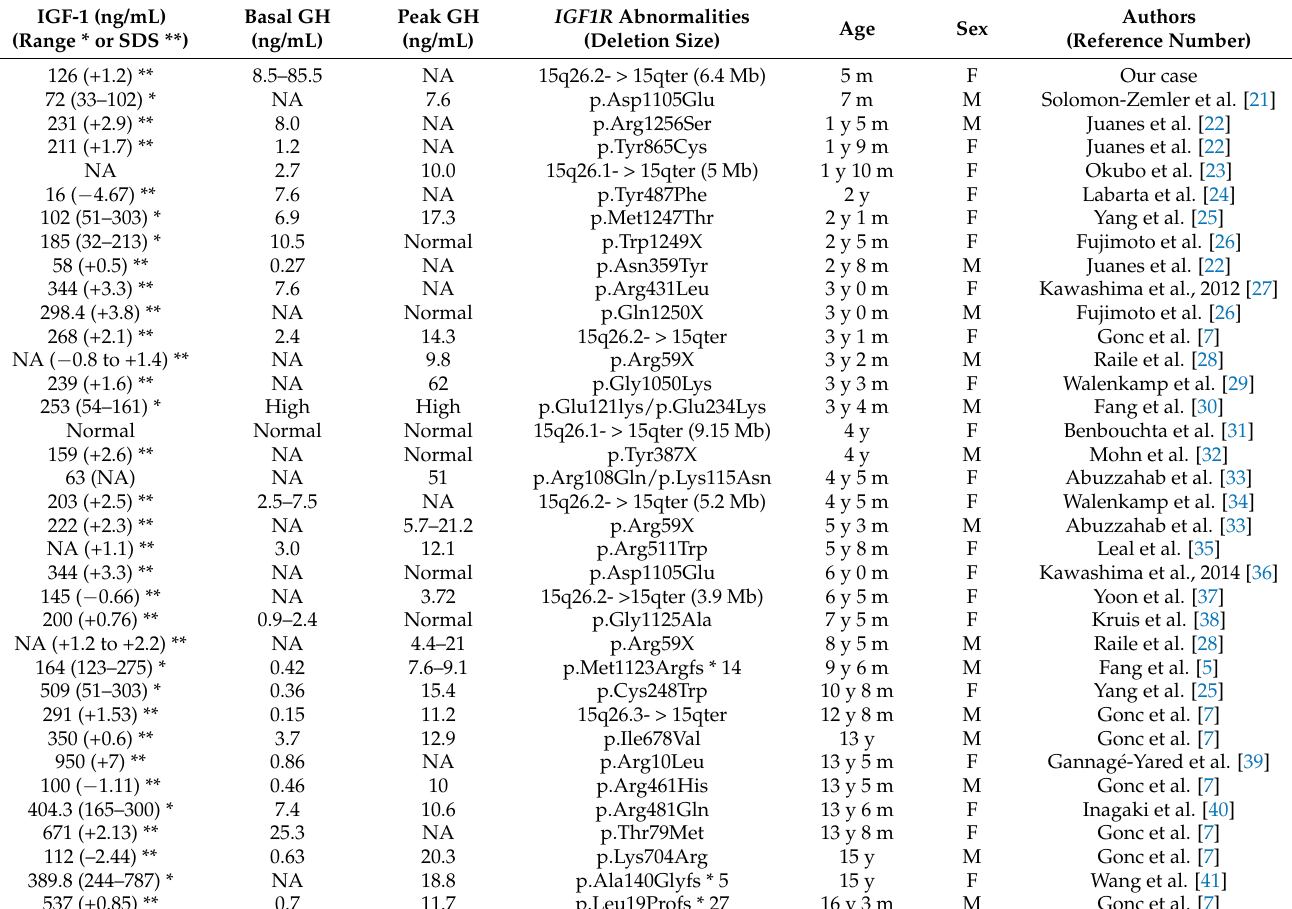
Table 2. Summary of IGF1R abnormalities with described serum GH levels in the previous